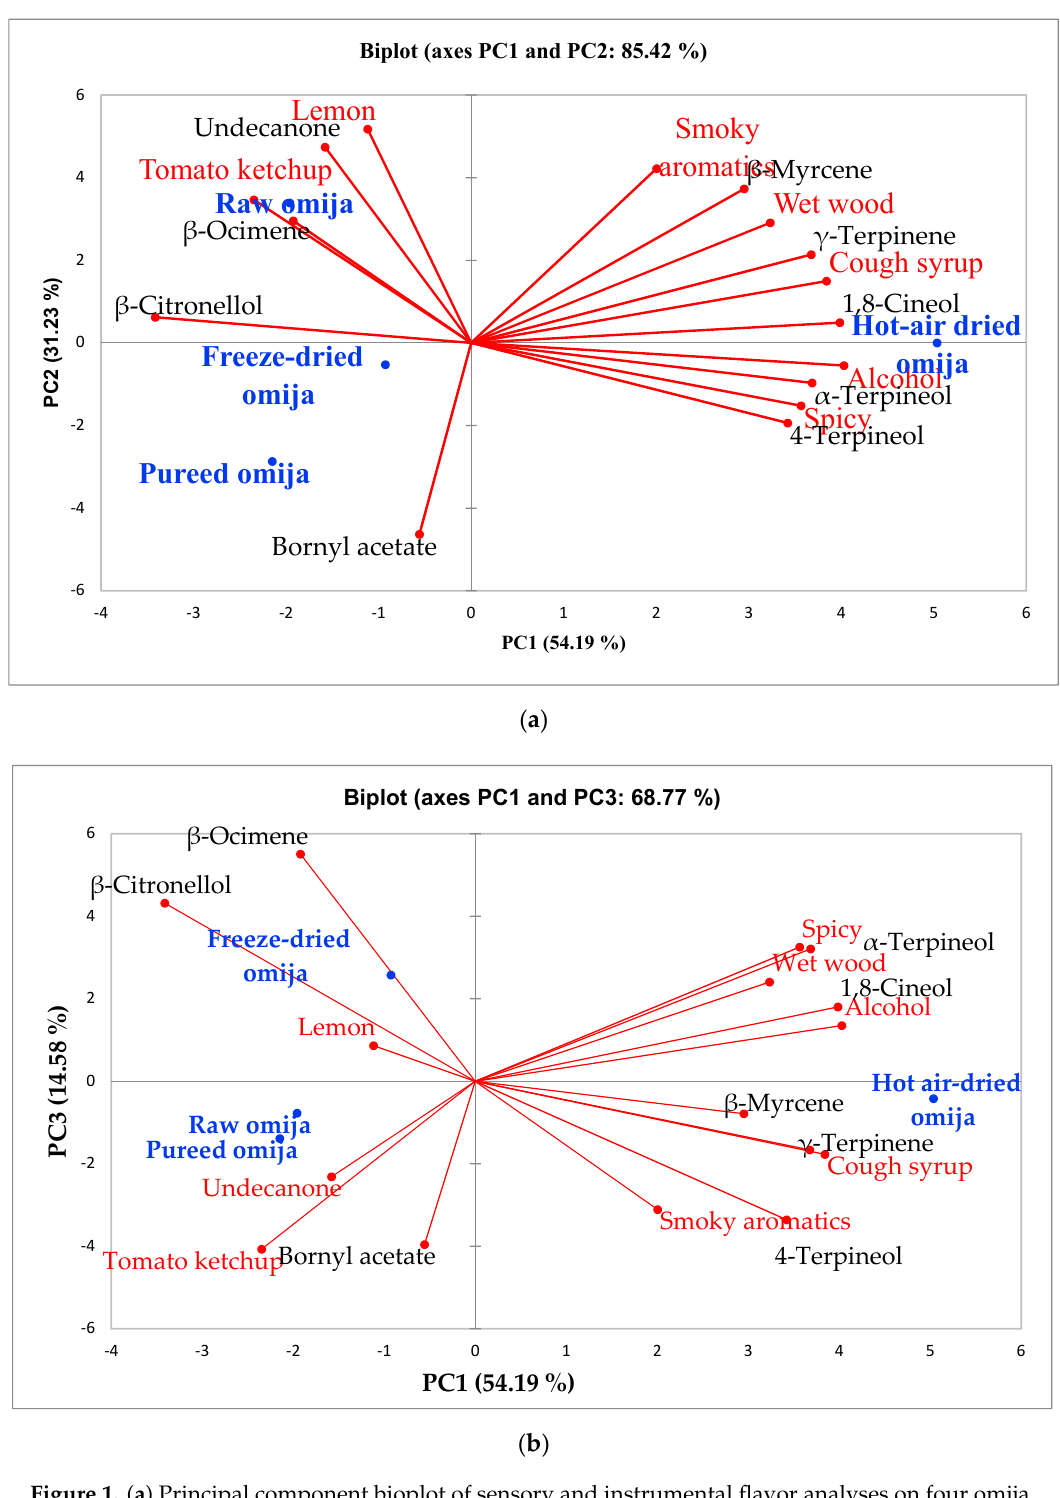
Figure 1. ( a ) Principal component bioplot of sensory and instrumental flavor analyses on four omija samples with PC1 and PC2. ( b ) Principal component bioplot of sensory and instrumental flavor analyses on four omija samples with PC1 and PC3.